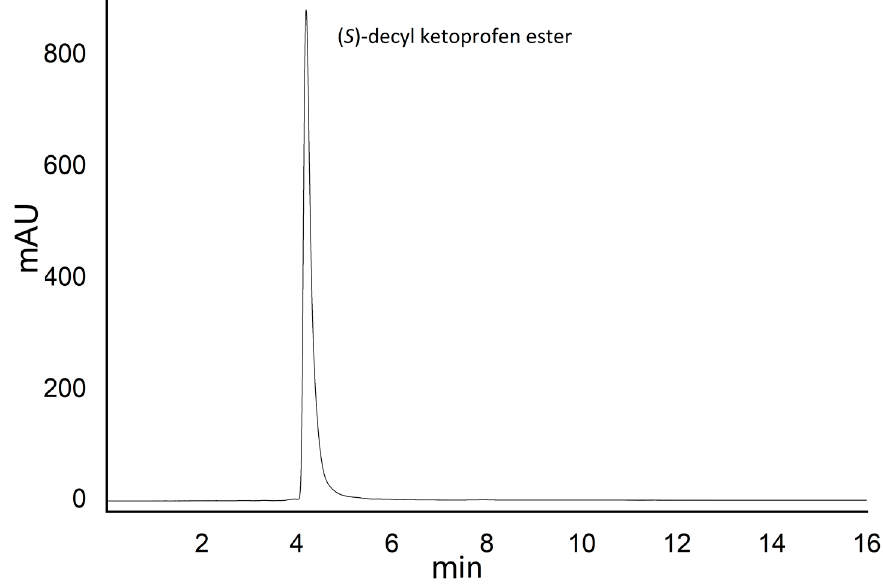
Figure 3. ( S )-decyl ketoprofen ester isolated chromatogram.